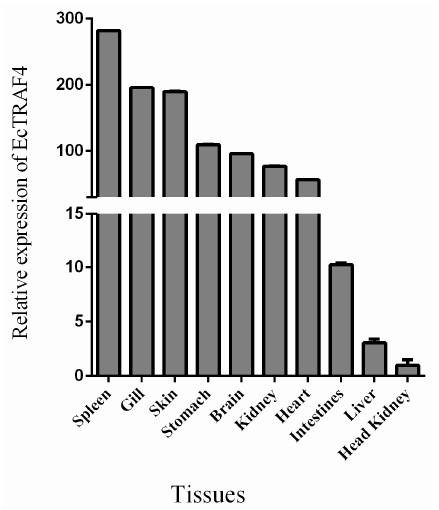
Figure 3. Tissue distribution of EcTRAF4 in healthy grouper. β -actin was used as the internal con- trol. The expression of EcTRAF4 in the head kidney was set to 1.0. Data are expressed as the mean fold change (means ± S.E., n = 3) from the head kidney.